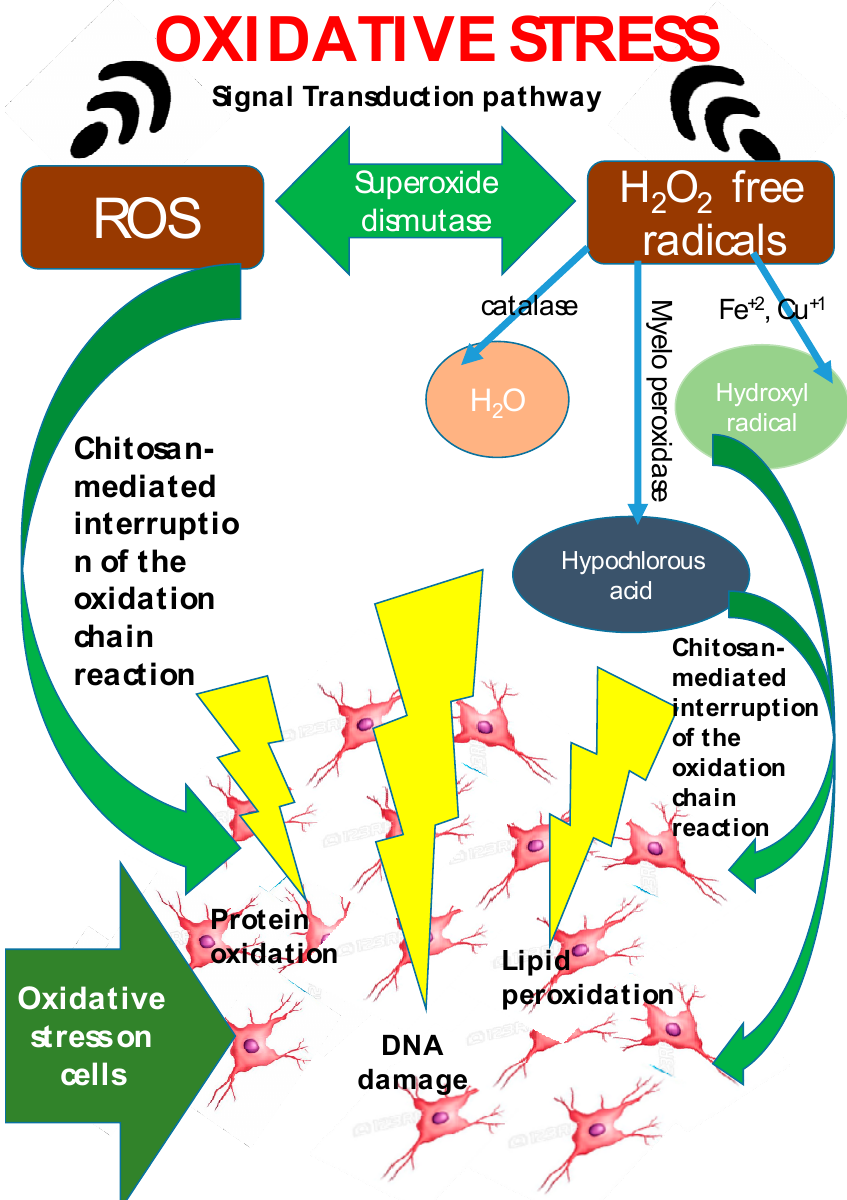
Figure 2. Schematic diagram showing the mode of action of antioxidant activity of chitosan via interruption of free radical chain reaction.